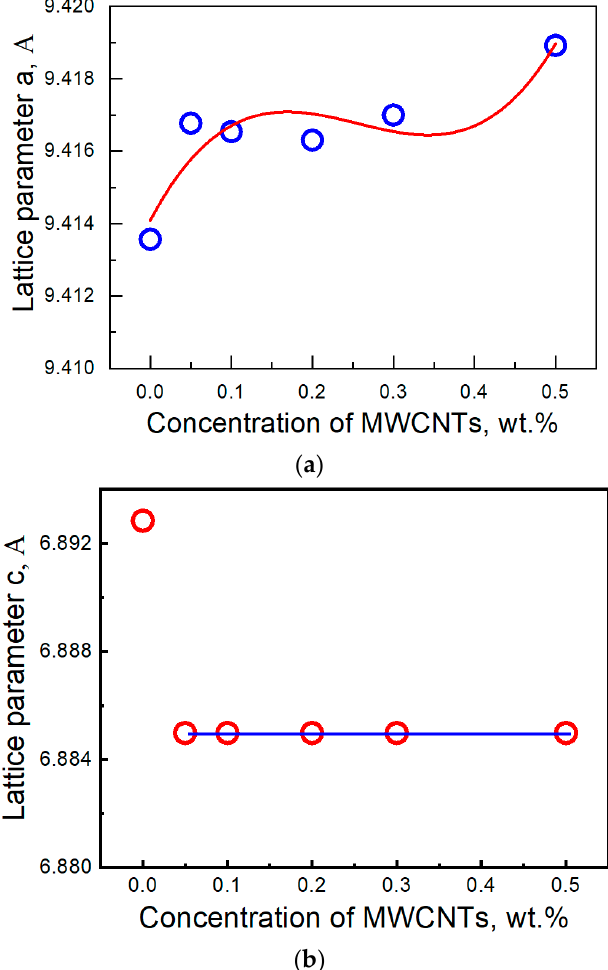
Figure 4. Lattice parameters (a = b, and c) for the hexagonal structure of the HAp composite ceramic vs. MWCNTs amount. Fittings of the experimental points for lattice parameters (a and c) are shown by ( a ) red and ( b ) blue lines, respectively.